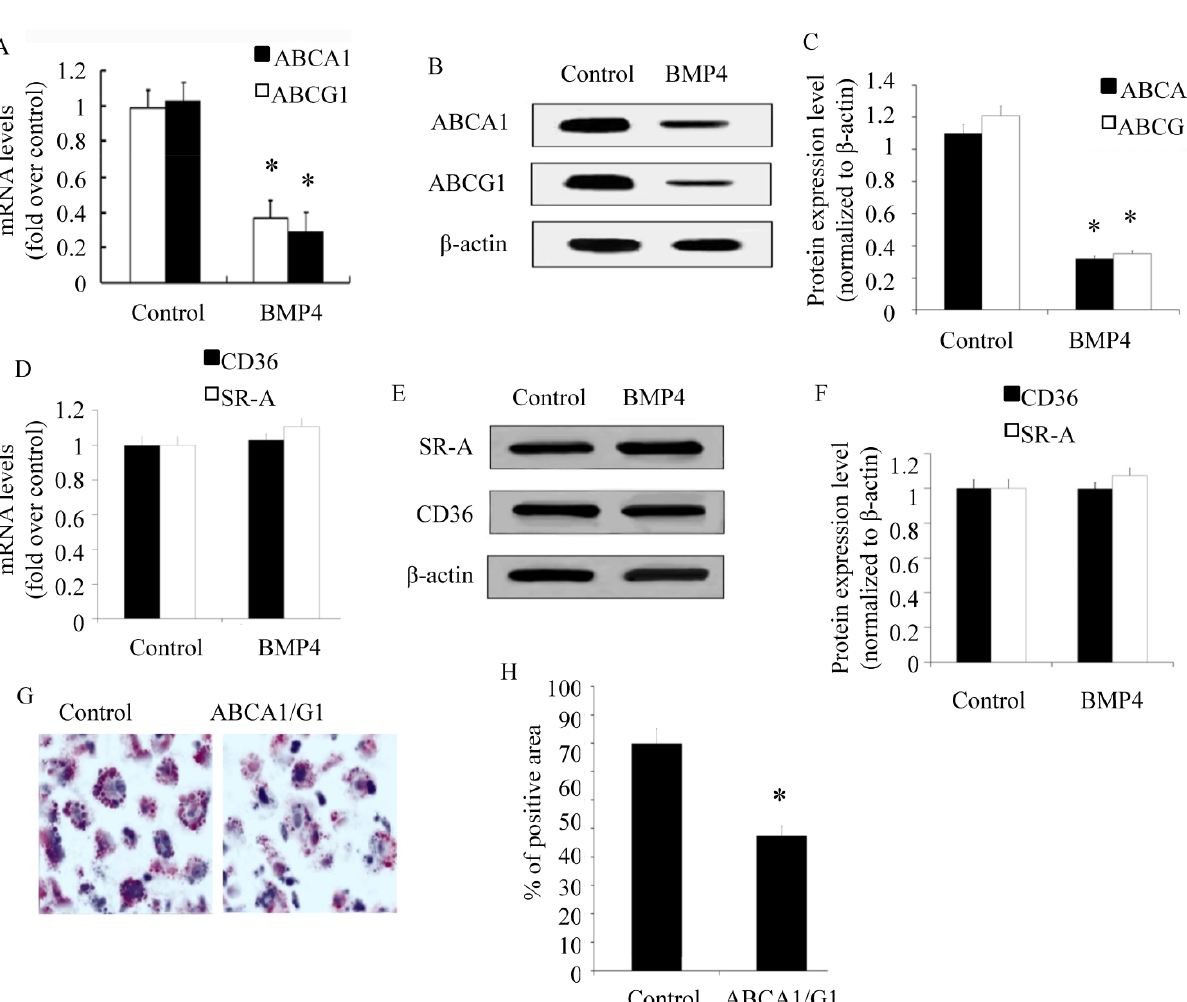
Figure 3. BMP4 inhibits ABCA1 and ABCG1 expression level. After treating with PBS (control) or BMP4, the expression levels of ABCA1 and ABCG1 were evaluated using RT-PCR ( A ) and Western blots ( B ), and the Western blots were quantified with relative densitometry to β-actin ( C ). Simultaneously, the expression levels of SR-A and CD36 were evaluated using RT-PCR ( D ) and Western blots ( E ), and the Western blots were quantified with relative densitometry to β-actin ( F ). After treating with BMP4, macrophages with null vector transfection (control) or ABCA1 and ABCG1 over-expression vector transfection, the foam cell formation of macrophages were detected using Oil red O ( G ), and was quantified with Oil red O positive area relative to macrophage area ( H ). * p <